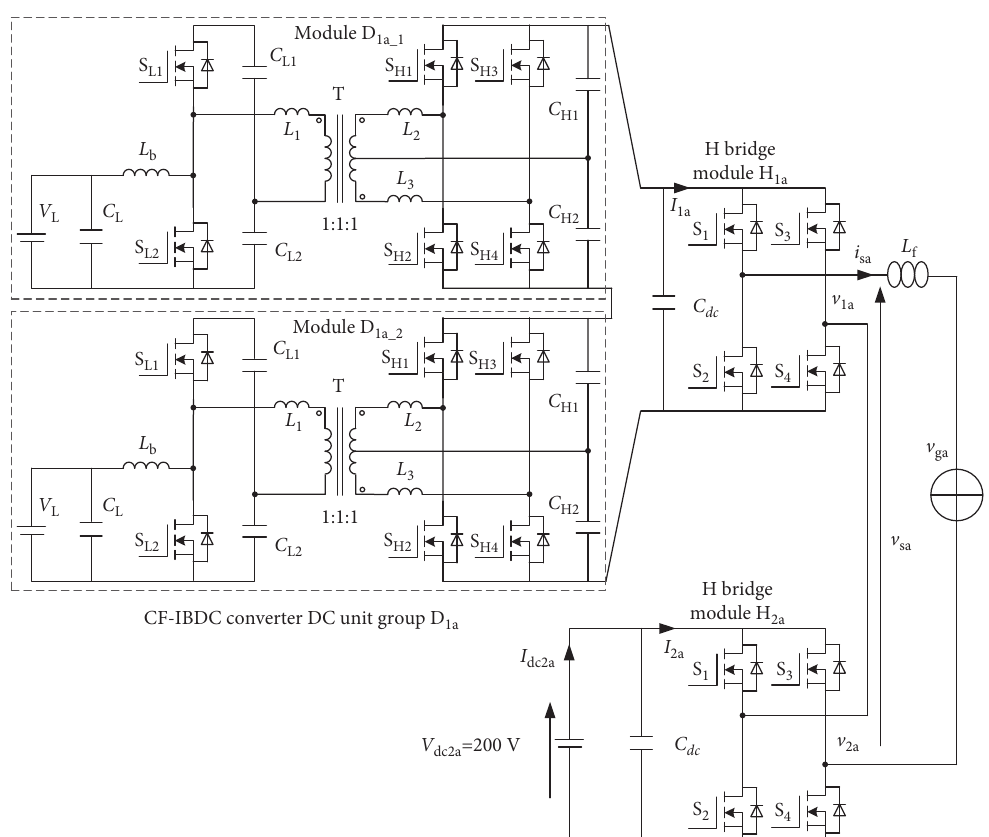
Figure 12: Experimental platform structure diagram.